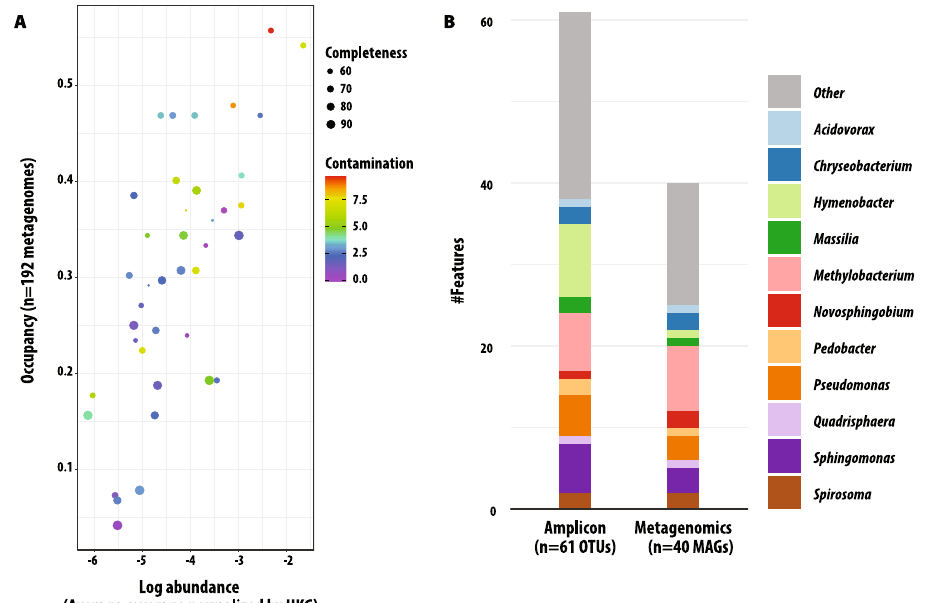
Fig. 3 | Summary of leaf-associated MAGs. A Abundance and occupancy of gen- omes assembled and binned from switchgrass and miscanthus phyllosphere metagenomes. Quality and contamination assessment were determined using checkM. 40 focal MAGs were selected. Occupancy is the proportion of the 192 metagenomes in which a MAG was detected, and abundance is the average nor- malizedbyhousekeepinggene(HKG)MAGcoverageacrossthe192metagenomes.